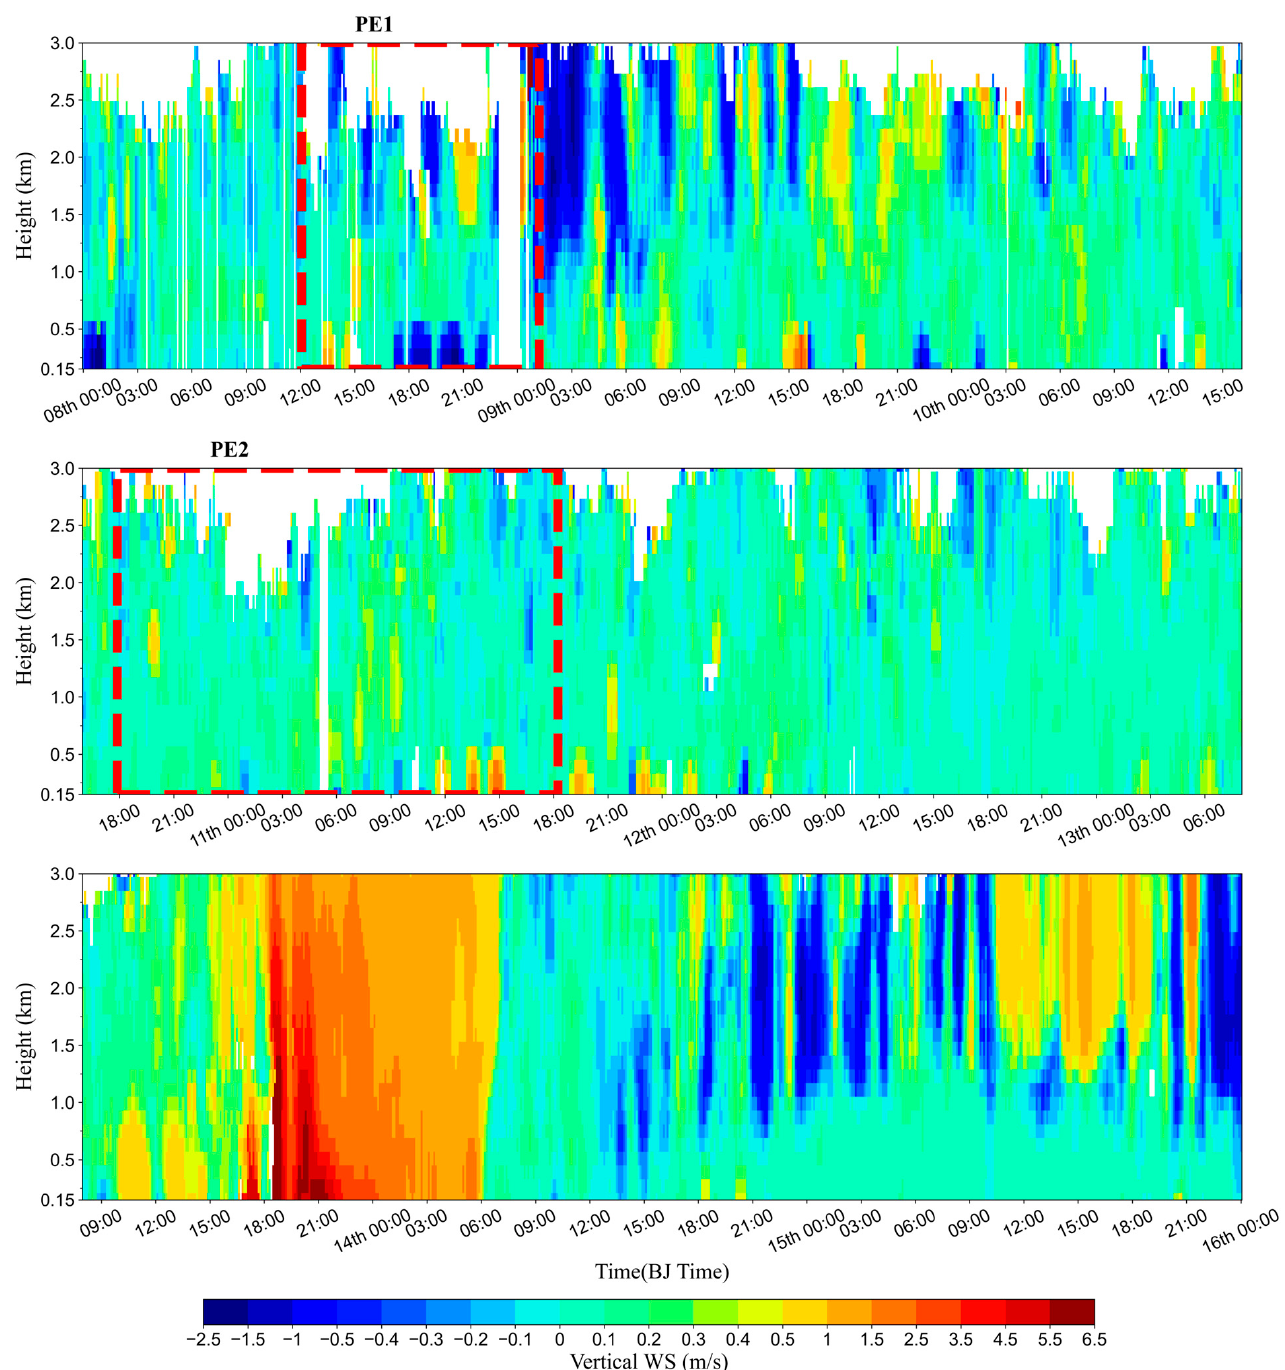
Figure 7. Vertical winds in urban Beijing from 8 to 15 February 2020. Positive values indicate downdrafts and negative values indicate updrafts.